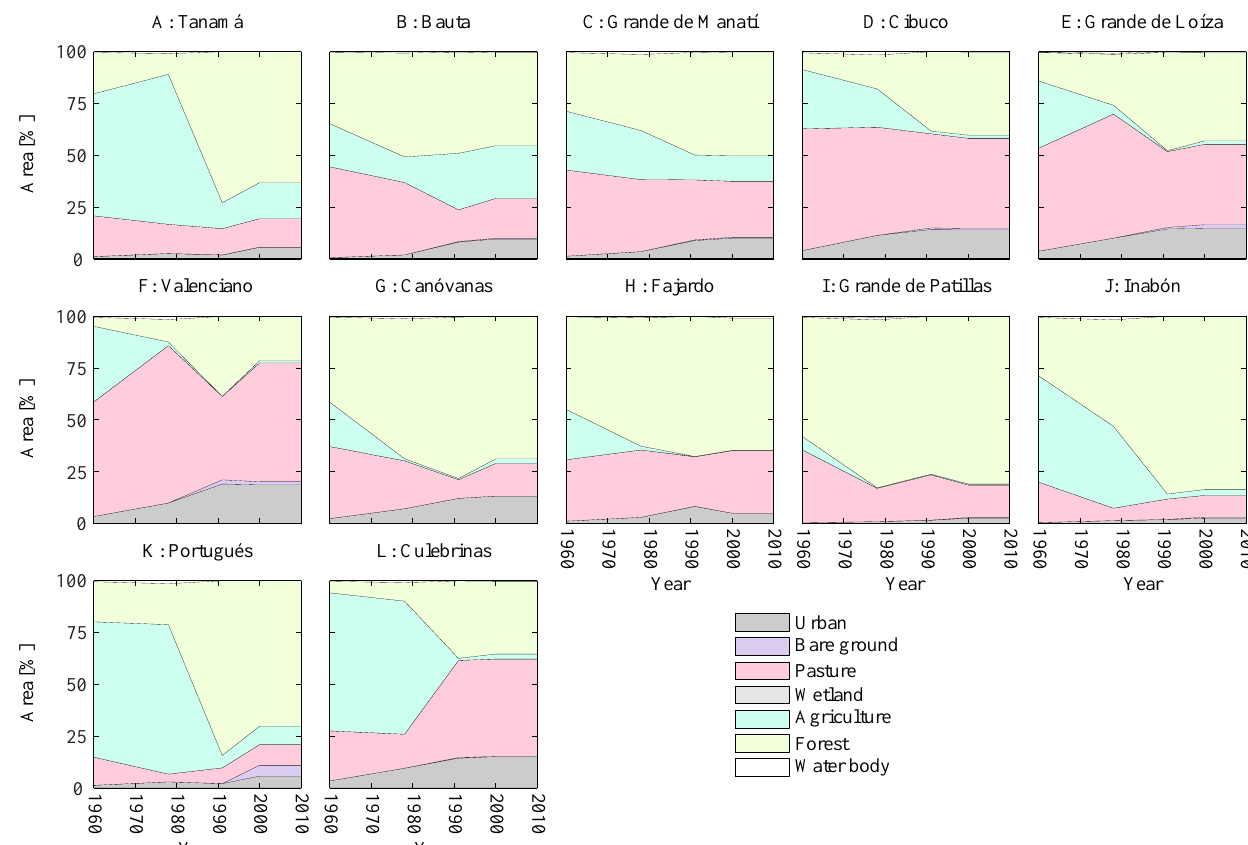
Fig. 5. Changes with time in area of the dominant land-cover types for the study catchments. Graphs are based on generalized (cf. Table 2) land-cover classification maps for the years 1951, 1978, 1991, and